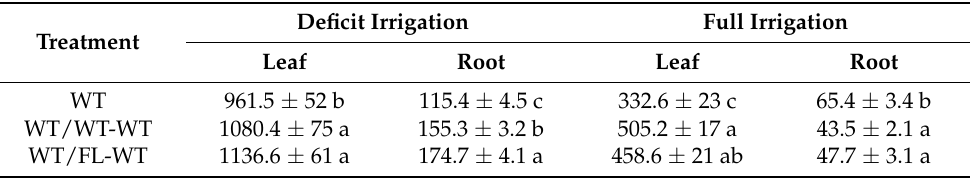
Figure 3. Variation of abaxial stomatal conductance (( a ) full irrigation, ( b ) deficit irrigation) of FL and WT in competing pot. The wild-type tomato and flacca mutant was planted in one pot (WT/FL) (** p < 0.01). Table 2. ABA concentration (ng g − 1 DW) in leaf and root of the single and competing WT tomato under full and deficit irrigation. Data are means ± standard error (SE). Different letters denote statistically significant differences between treatments ( p < 0.05).